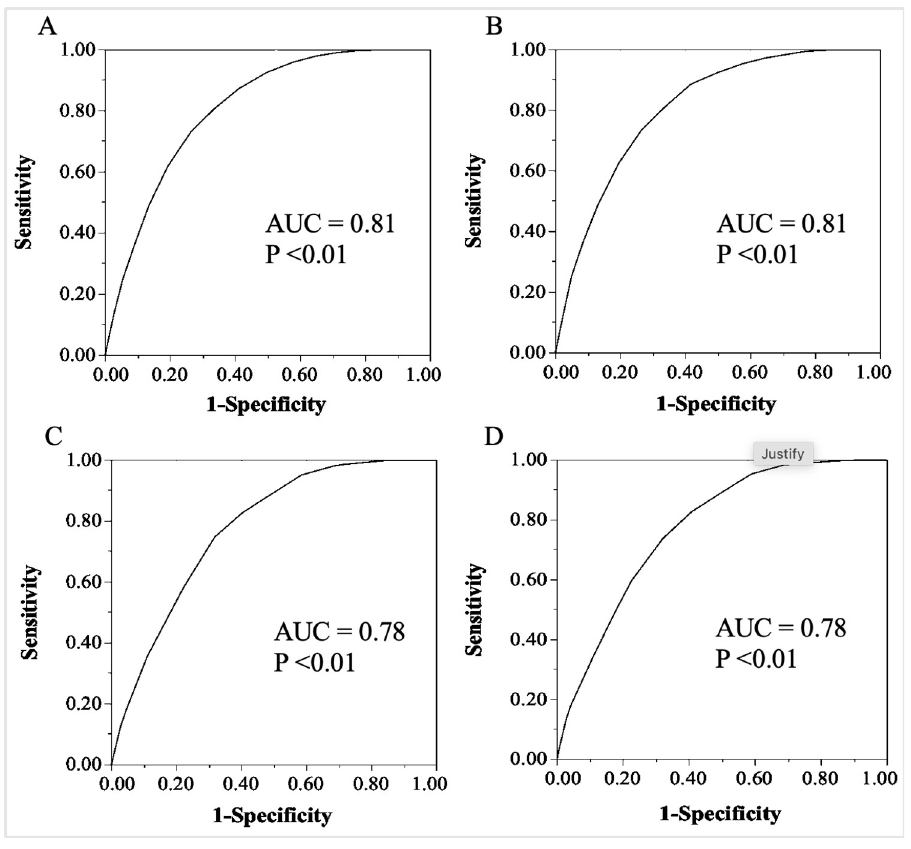
Fig 2. Five-year metabolic syndrome risk score prediction ability for the primary and the simple score model (excluding blood tests) in derivation and validation cohorts. The predictive ability of the primary and simple model was assessed using ROC curve analysis to determine the AUC for the derivation and validation cohorts. A. Primary score derivation cohort B. Primary score validation cohort C. Simple score derivation cohort, and D. Simple score validation